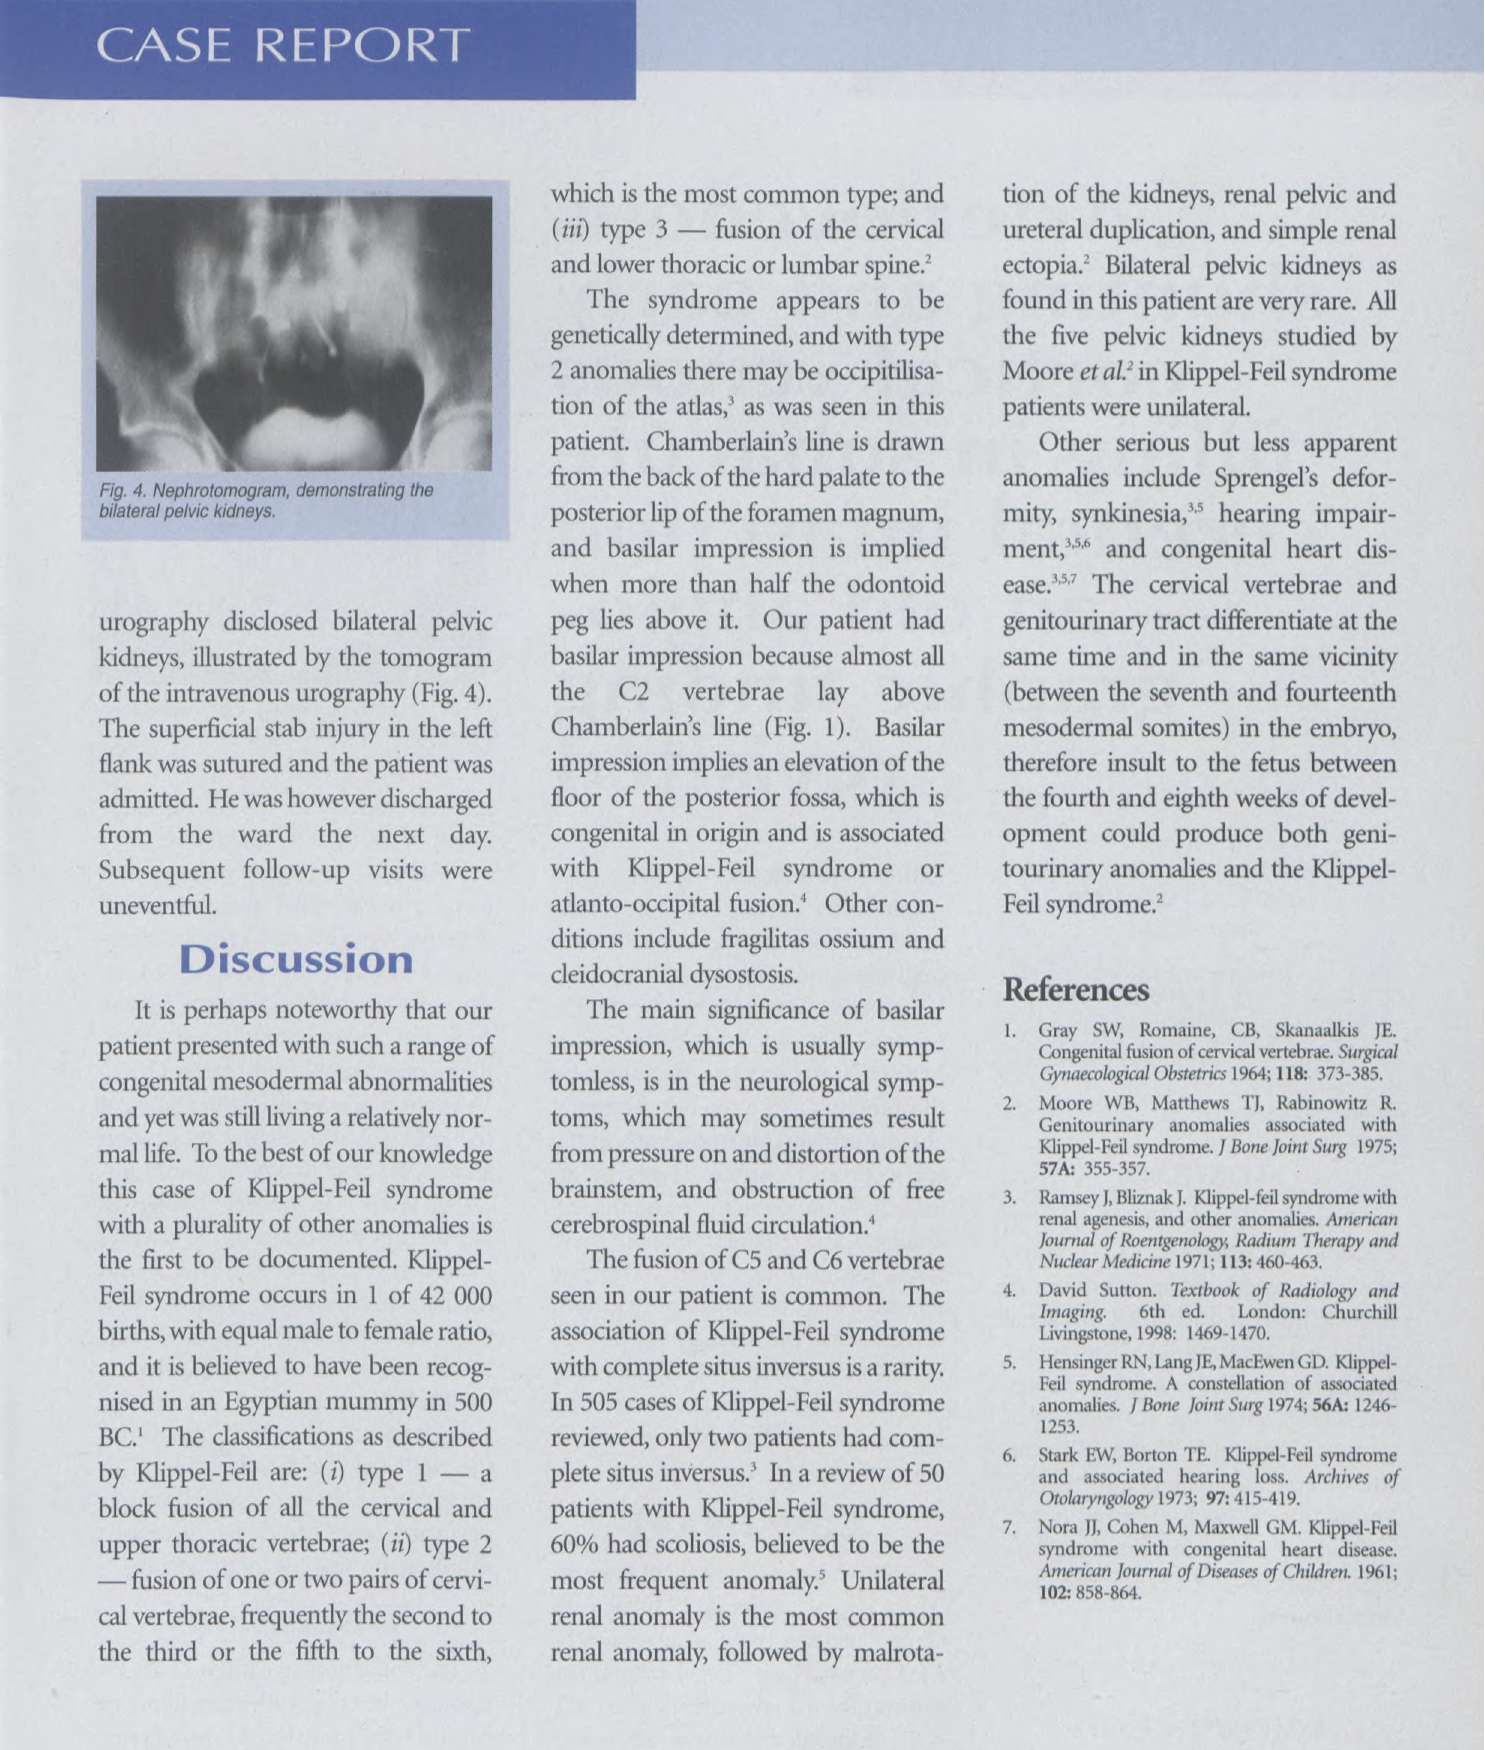
Fig. 4. Nephrotomogram, demonstrating the bilateral pelvic kidneys.